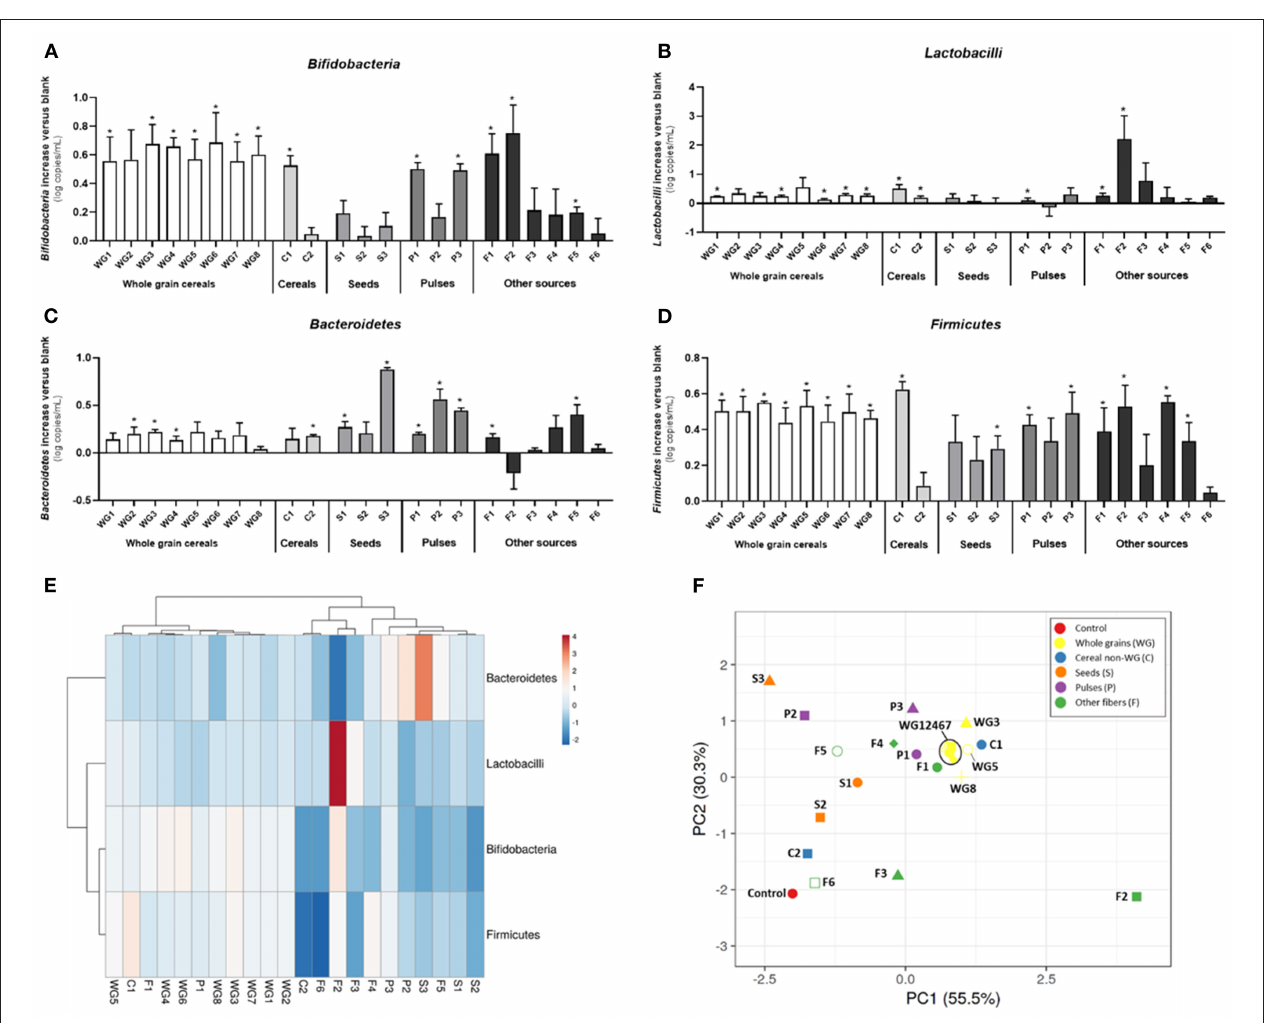
FIGURE 3 | Effect of dietary fibers on absolute abundance of bifidobacteria, lactobacilli, Bacteroidetes, and Firmicutes. Bars represent the increase of bifidobacteria (A) , lactobacilli (B) , Bacteroidetes (C) , and Firmicutes (D) vs. the control condition (average of three donors, technical triplicate per donor ± SD) after exposure to different products for 48h. Heatmap of Pearson’s correlation analysis between absolute abundance of bifidobacteria, lactobacilli, Bacteroidetes, and Firmicutes and different fibers (E) . PCA of different bacterial groups after treatments (F) . WG1, whole grain millet; WG2, whole grain oat; WG3, medium grain whole brown rice; WG4, whole grain soft white wheat; WG5, whole grain barley; WG6, whole grain corn; WG7, waxy whole grain soft white wheat; WG8, waxy hulless barley; C1, oat beta glucan; C2, rice fiber; S1, whole brown flaxseed; S2, hemp seeds; S3, psyllium fiber; P1, whole brown lentils; P2, soy fiber; P3, pea fiber; F1, kiwi fiber; F2, inulin; F3, bamboo fiber; F4, konjac flour; F5, apple fiber; F6, algal beta glucan isolate.